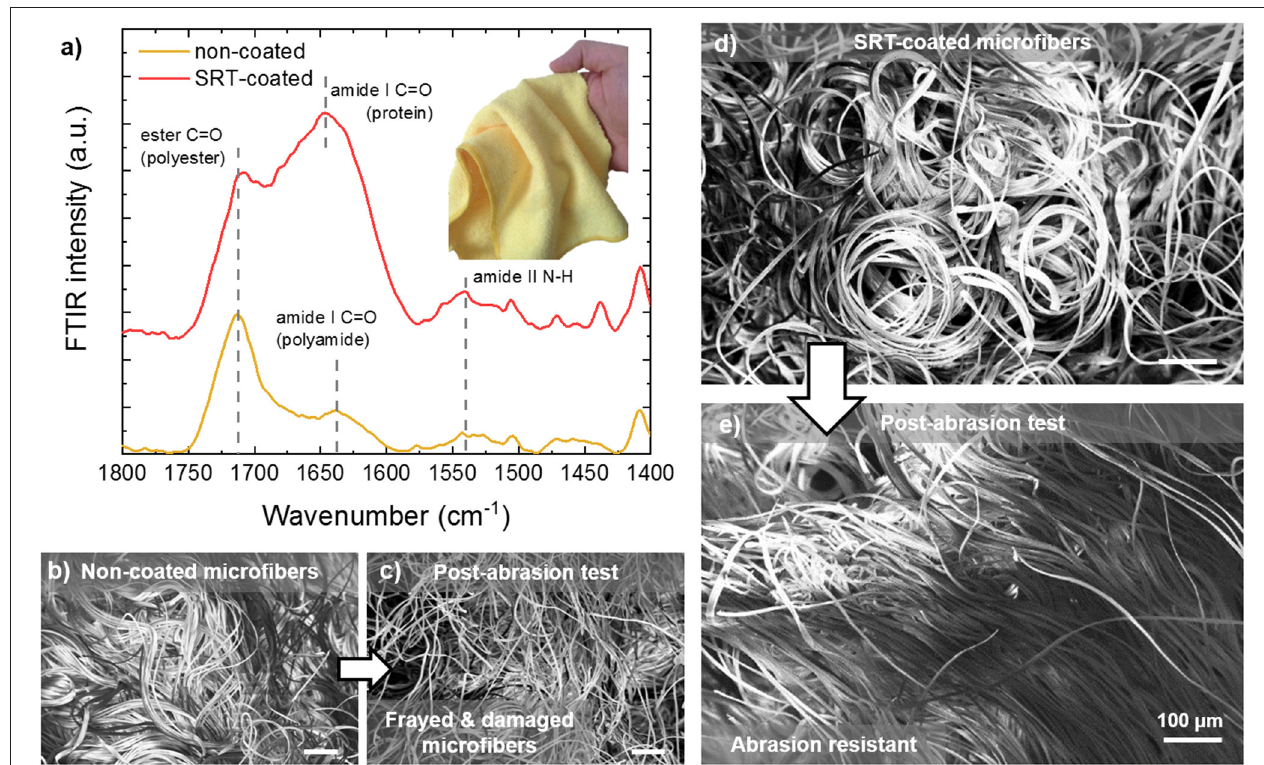
FIGURE 5 | Abrasion-resistant SRT protein coatings for advanced textiles. (a) FTIR spectra of SRT-coated and non-coated microfiber cloth. (b) Pre-abrasion non-coated microfibers are bundled, but they are (c) damaged and frayed after the abrasion test. (d) Pre-abrasion SRT-coated microfibers are bundled as well, but (e) after the abrasion test the microfibers are aligned and not